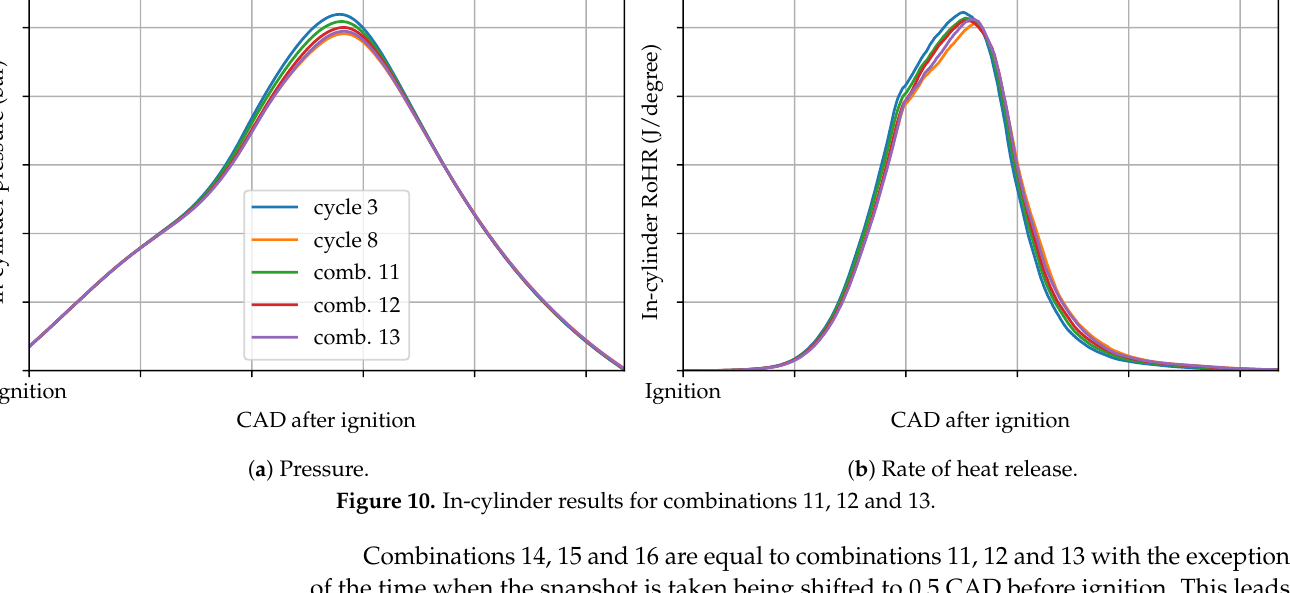
Figure 9. In-cylinder results for combinations 8, 9 and 10. Combinations 11, 12 and 13, shown in Figure 10, are similar to combinations 5, 6 and 7; only the original cycles are exchanged, i.e., a peak pressure of 0% corresponds to the cycle where the near-ignition flow field comes from. Again, a larger sphere of exchange region means a lower peak pressure, going from 63.2% for the 1 cm sphere to 32.5% for the 2 cm sphere and as low as 12.7% for the largest sphere of 5 cm.